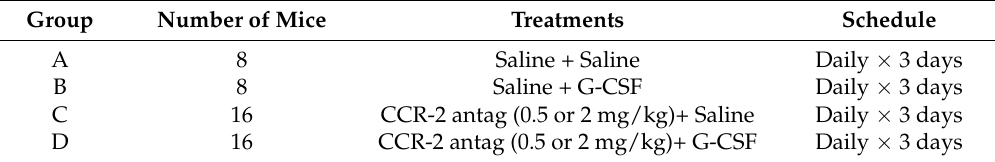
Table 1. Schedule of G-CSF and CCR-2 antagonist